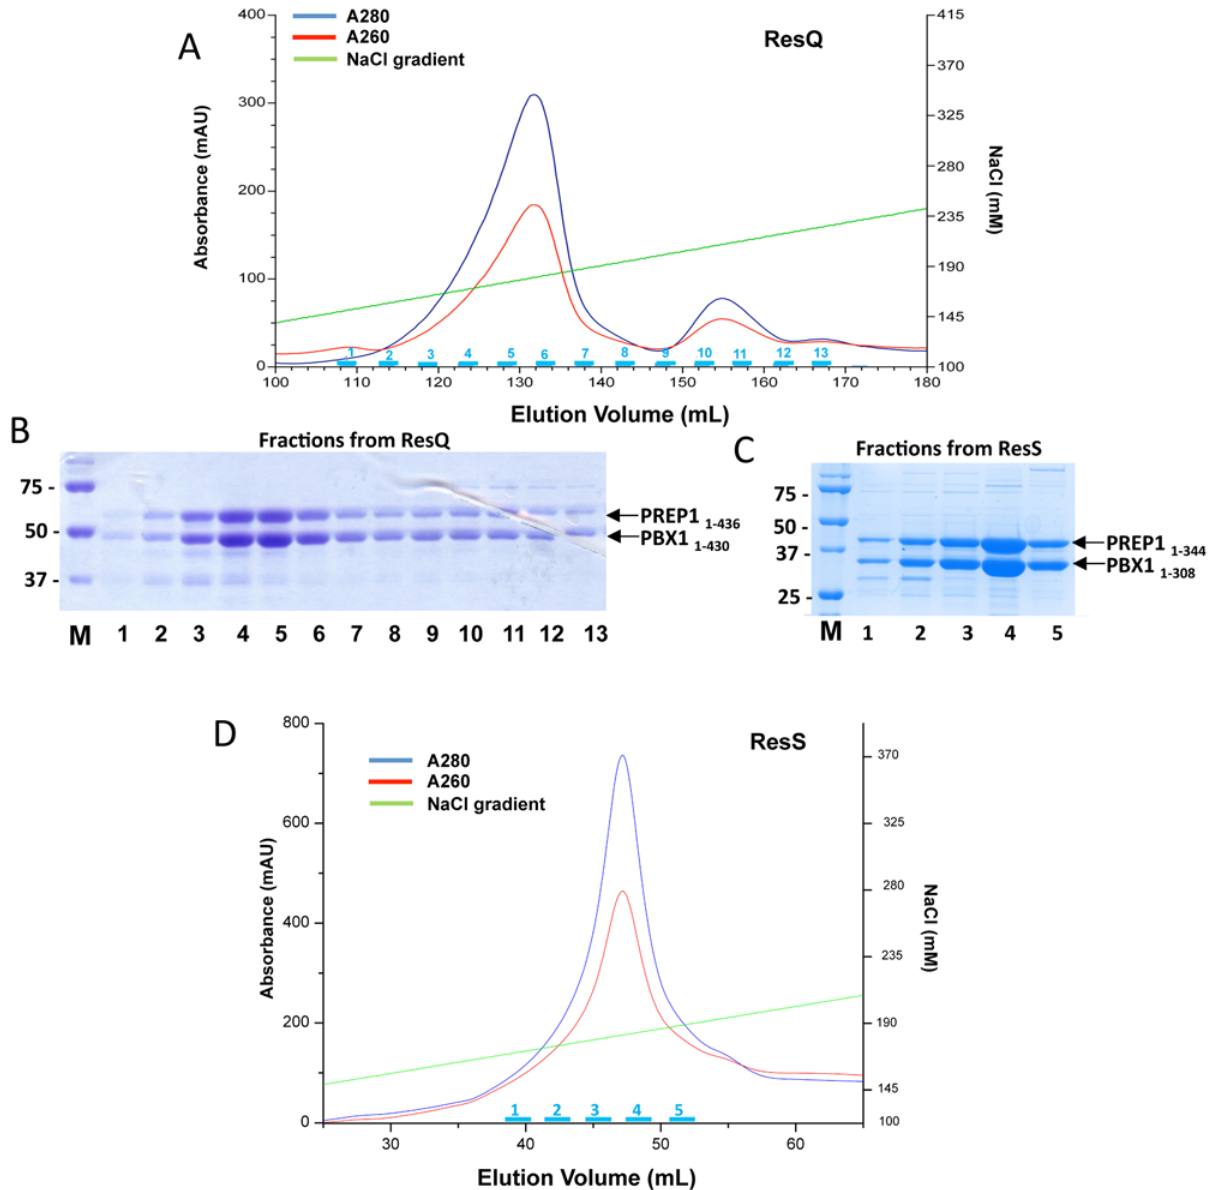
Fig 3. Ion exchange purifications of full-length PBX1:PREP1 and C-terminally truncated PBX1 1 – 308 :PREP1 1 – 344 complexes. A. Co-expressed and purified full-length PBX1:PREP1 complex was loaded onto a Res Q anion exchange column and eluted with a 0.1 – 1 M NaCl gradient. B. SDS PAGE of fractions from anion exchange of full-length PBX1:PREP1. Lane M, Bio-Rad size standard; lanes 1 – 13, fractions indicated in cyan in the above chromatogram; fraction volume was 1.5 ml, and on SDS PAGE were loaded 10 μ l of each fraction C. SDS PAGE of fractions from anion exchange column of PBX1 1 – 308 :PREP1 1 – 344 . Lane M, Bio-Rad size standard; lanes 1 – 5, fractions indicated in cyan in the chromatogram below; fraction volume was 1.5 ml, and on SDS PAGE were loaded 10 μ l of each fraction D. Co-expressed and purified PBX1 1 – 308 :PREP1 1 – 344 complex was loaded onto a Res S cation exchange column and eluted with a 0.1 – 1 M NaCl